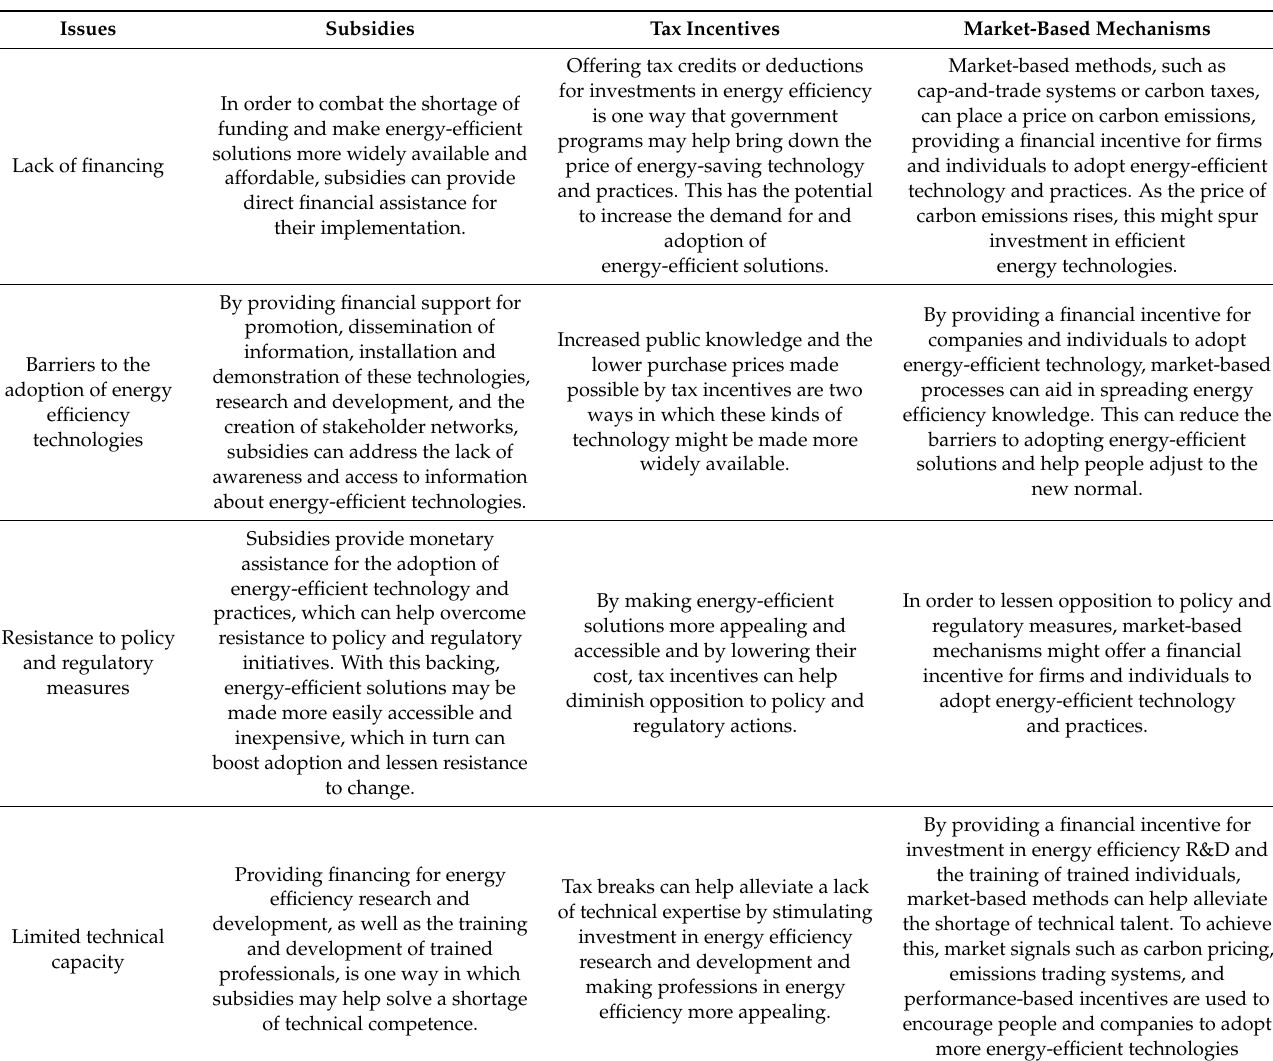
Table 4. Solution of the problems faced in implementation of efficient energy consumption through economic